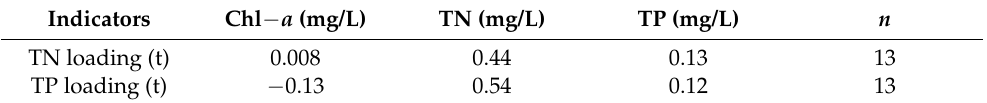
Figure 8. Proportion of external loadings of TN ( a ) and TP ( b ) in the main inflow rivers. Table 5. Pearson’s correlation between river loadings and water quality parameters from 2007 to 2019.